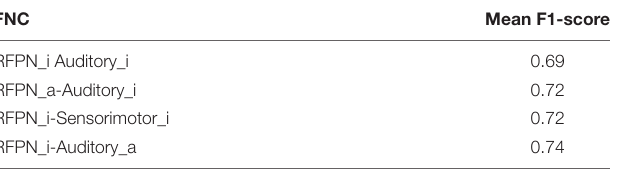
TABLE 2 | The comprehensive results of the classification performance for a single feature.